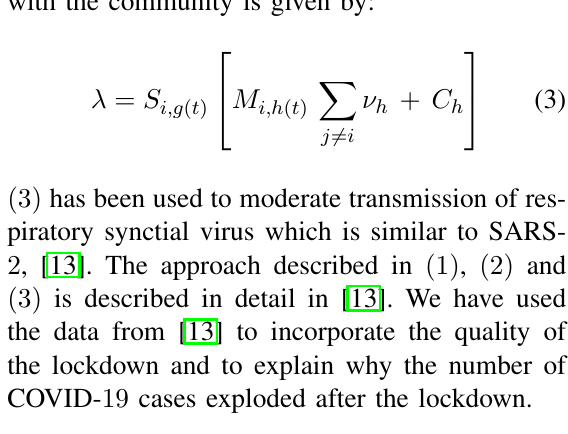
h at time t during the lockdown. The rate of exposure from a member of the family j to i is given by: